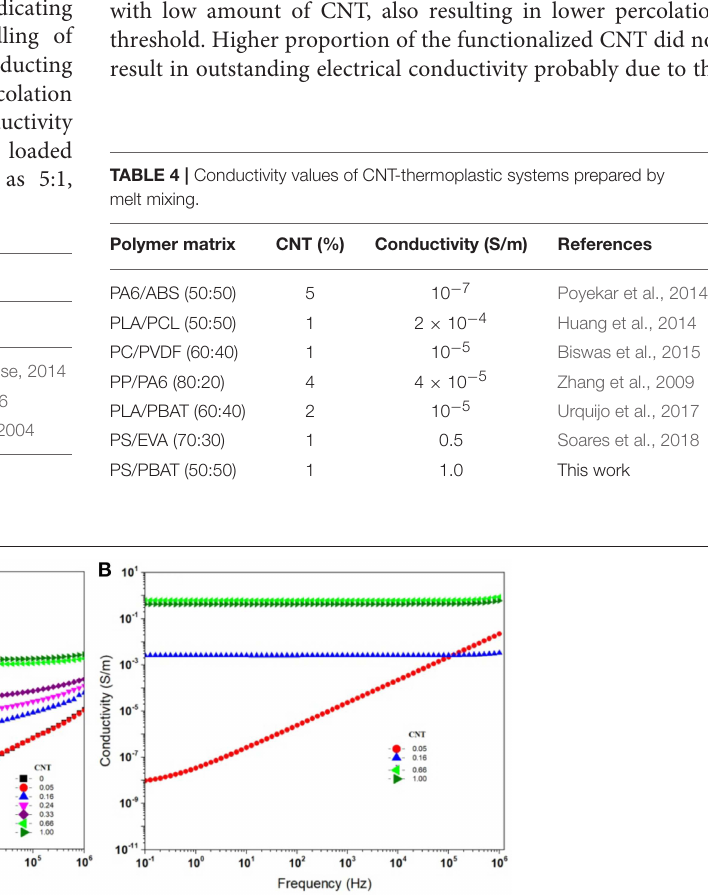
Frontiers in Materials |